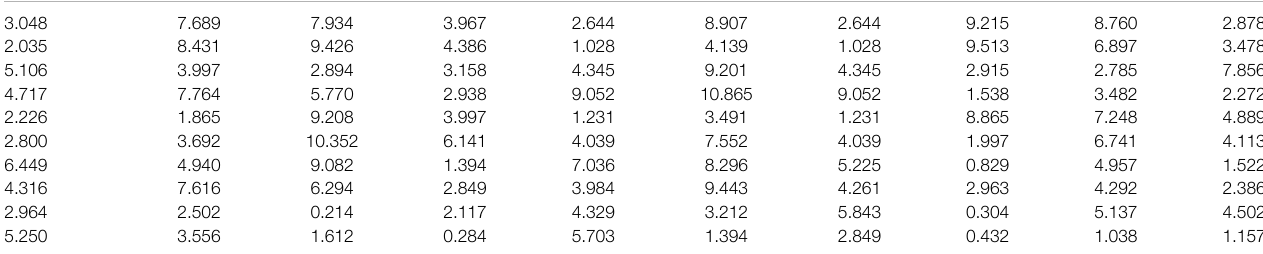
TABLE 1 | The amount of information on the satisfaction of logistics service users to the